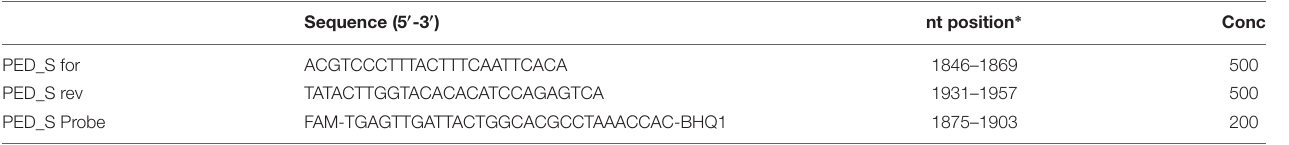
TABLE 2 | Primer/probe sequences and concentrations (nM) used in quantitative real-time PCR (qPCR) assay. Sequence (5 (cid:48) -3 (cid:48) )